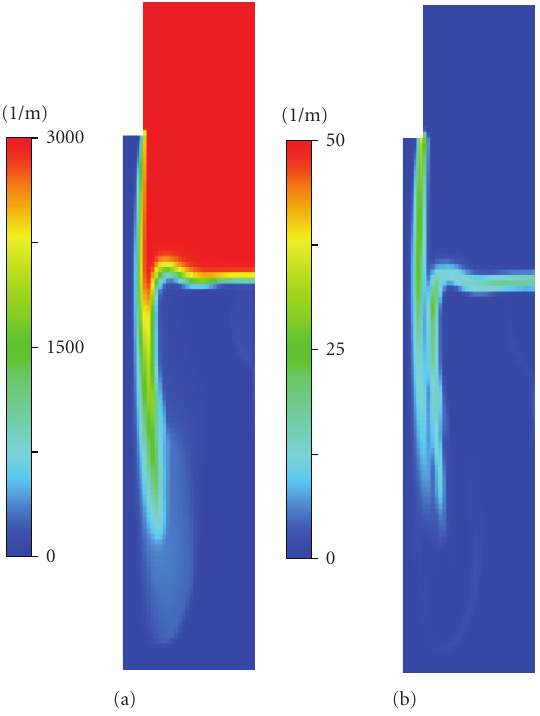
Figure 15: (a) Bubble projected area density a B . (b) Free surface area density a S